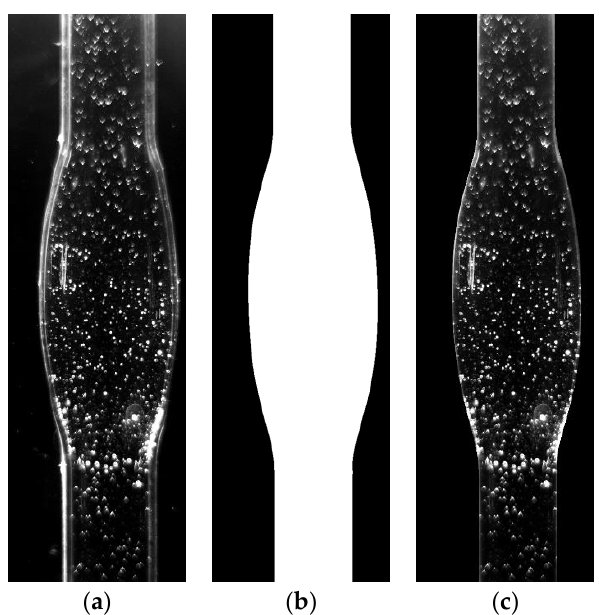
Figure A1. Example of ( a ) an acquired image, ( b ) the reconstructed vessel boundaries, ( c ) the image resulting after the masking procedure .